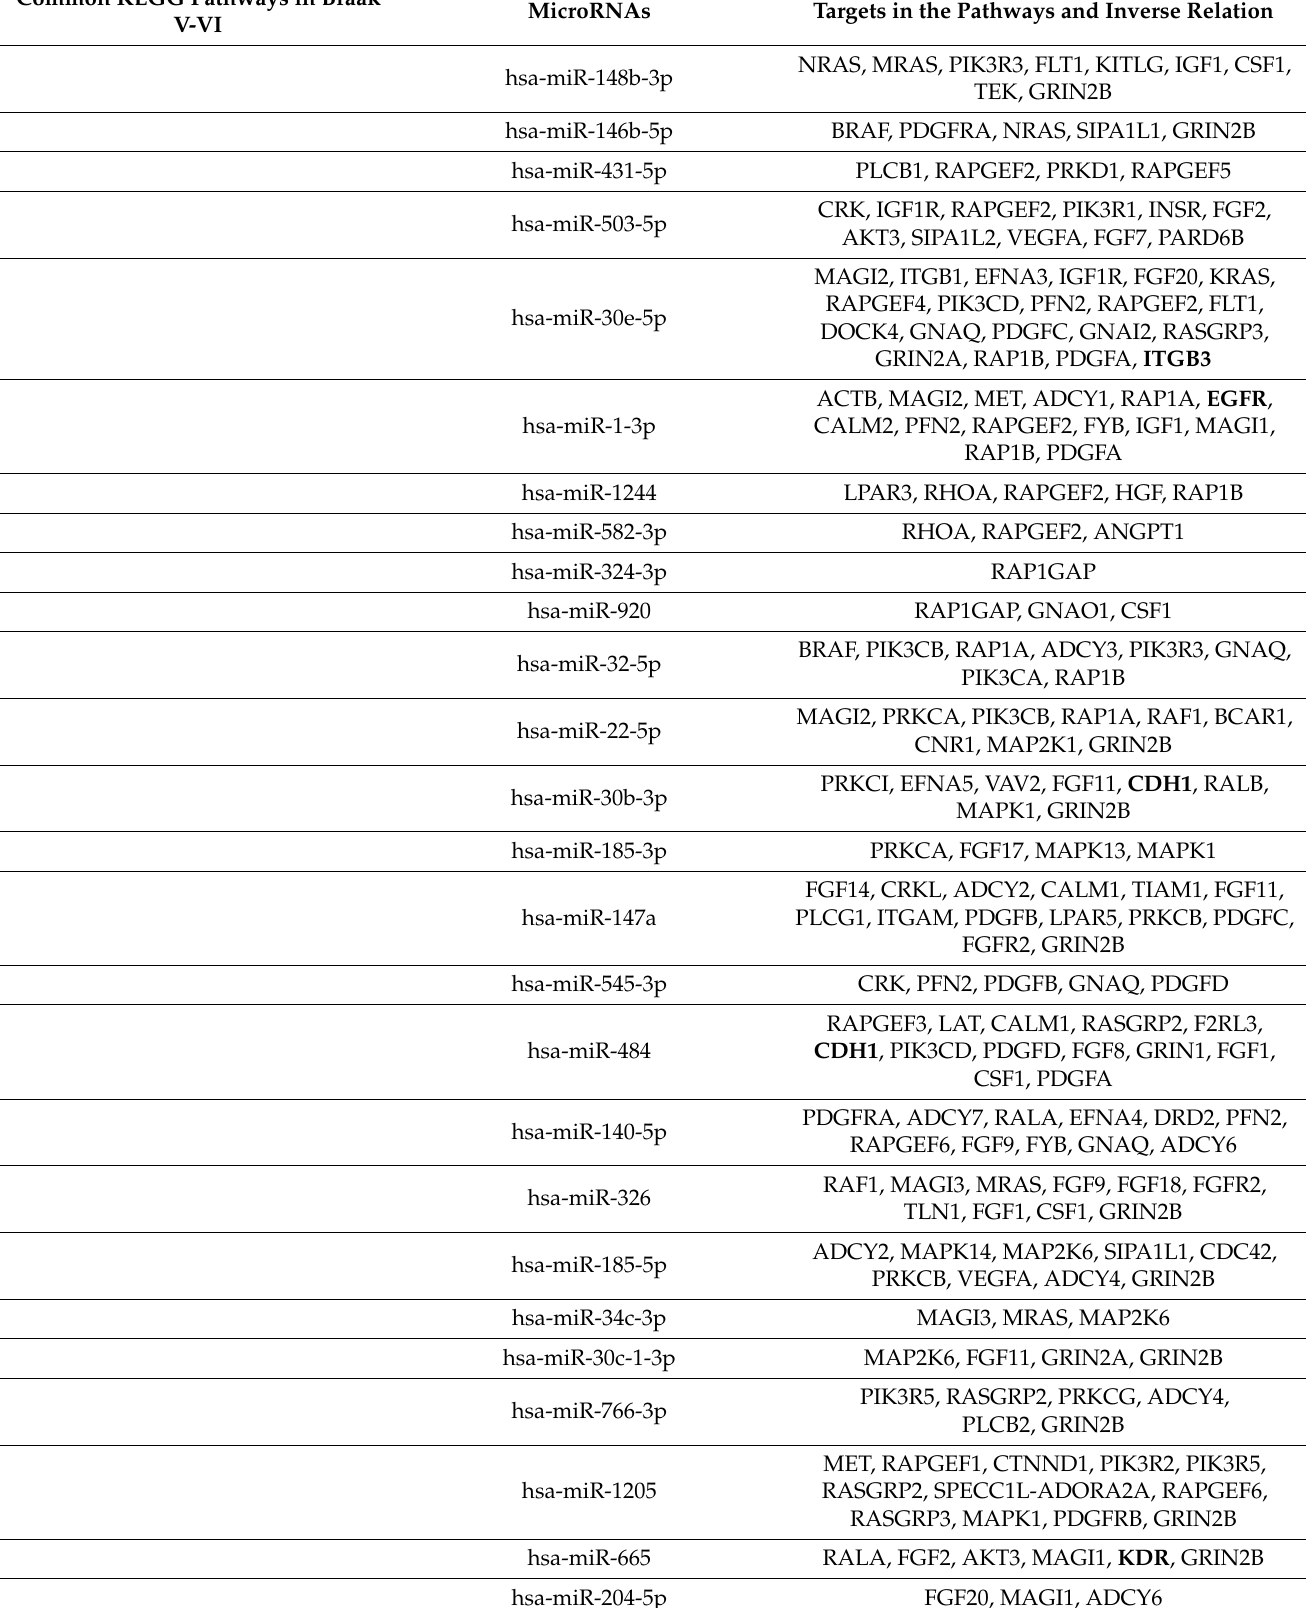
Common KEGG Pathways in